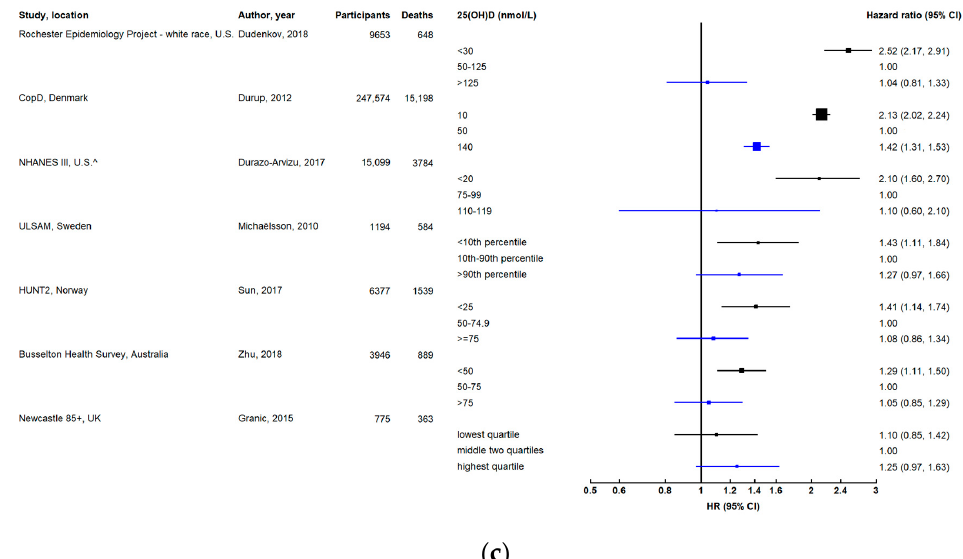
Figure 2. Results from prospective studies investigating all-cause mortality in relation to 25-hydroxyvitamin D (25(OH)D) concentration: ( a ) comparing low versus high concentrations categorically; ( b ) continuously, for a decrement in 25(OH)D concentration; ( c ) low (black) and high (blue) concentrations compared with levels in the middle of the 25(OH)D distribution. The squares represent hazard ratios, and horizontal lines are the 95% confidence intervals. Studies that estimated odds ratios or relative risks are denoted by * and ^, respectively. Axes are scaled differently in each panel to maximize the visualization of effect estimates.